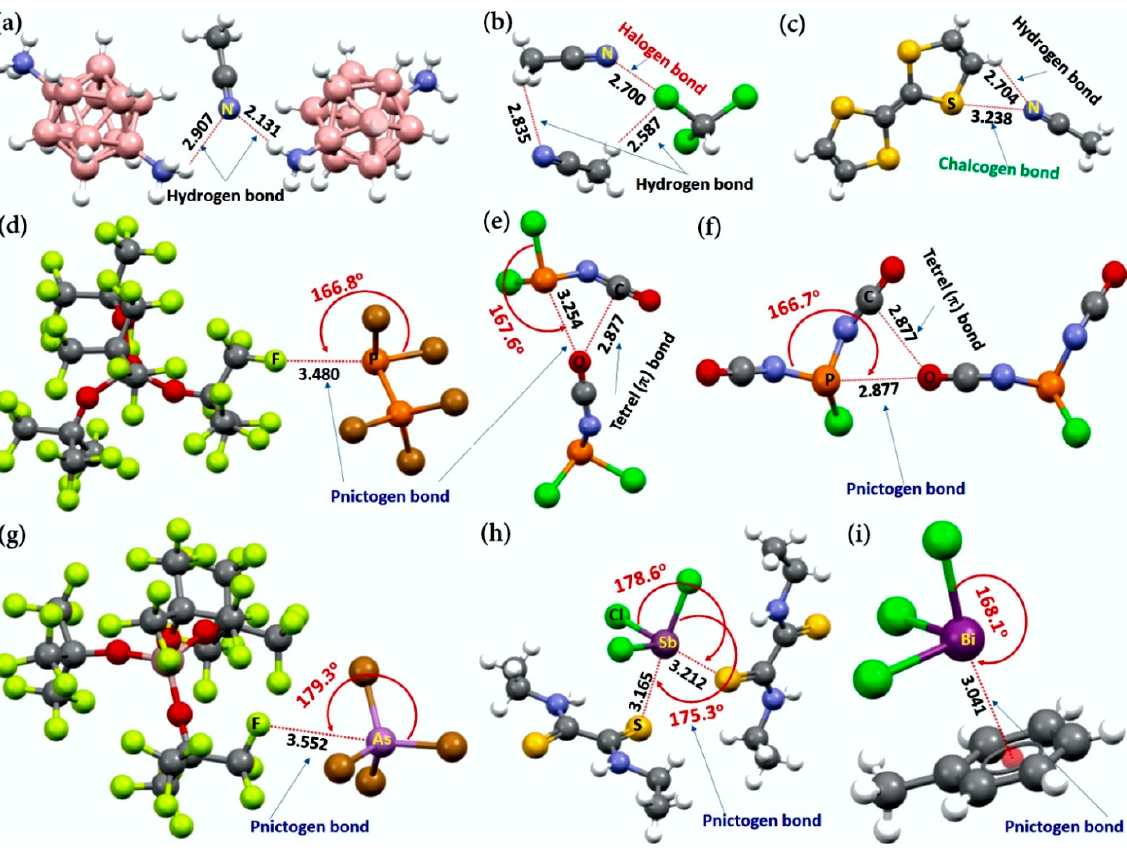
Figure 1. Illustration of various types of non-covalent interactions between building blocks found in selected crystalline materials: ( a ) 1,12-diammonia-closo-dodecaborate acetonitrile solvate (CSD ref: